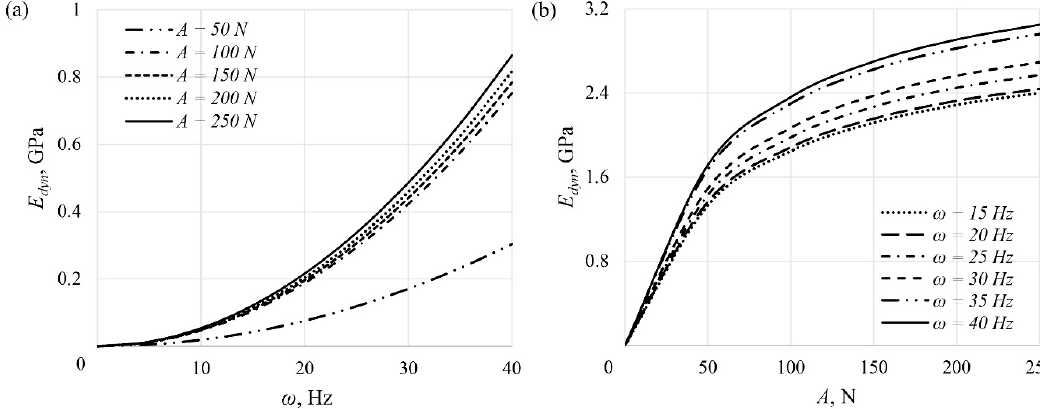
Figure 4. Experimental results on the dry sandstone dynamic Young’s modulus 𝐸 (cid:3031)(cid:3052)(cid:3041) : ( a ) dependence of 𝐸 (cid:3031)(cid:3052)(cid:3041) on load frequency 𝜔 ; ( b ) dependence of 𝐸 (cid:3031)(cid:3052)(cid:3041) on load amplitude 𝐴 .